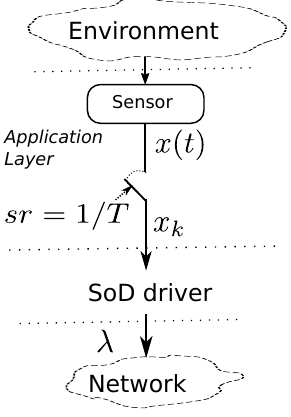
Figure 1. Discretized ( x k ) raw signal ( x ( t )